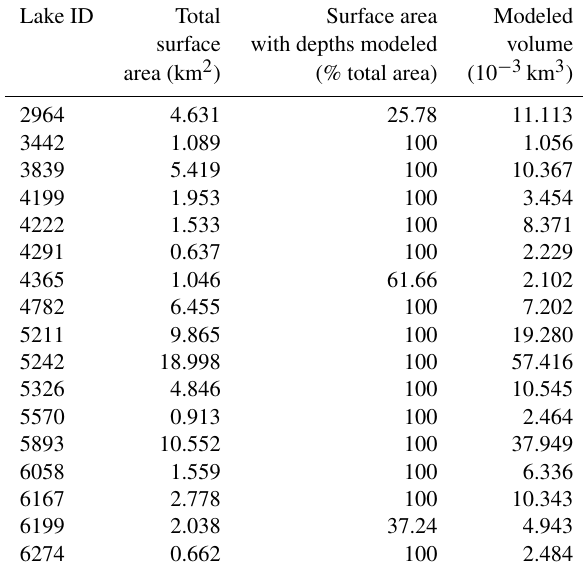
Table 4. Modeled lake volumes. Individual lake volumes were esti- mated by multiplying the modeled depth for each pixel by a constant factor of 900m 2 (Landsat spatial resolution). Depths were modeled by applying the best spectral-depth model for the lake (Table 3). Linear depth models predicted negative depths for some pixels; vol- ume estimates derived from such models (namely the models ap- plied at lakes 2964, 4365, and 6199) include only those pixels with modeled depths greater than zero. The percent of the surface area for which depth estimates at a lake were positive (in contrast to the total surface area of a given lake derived using the NDWI mask) is